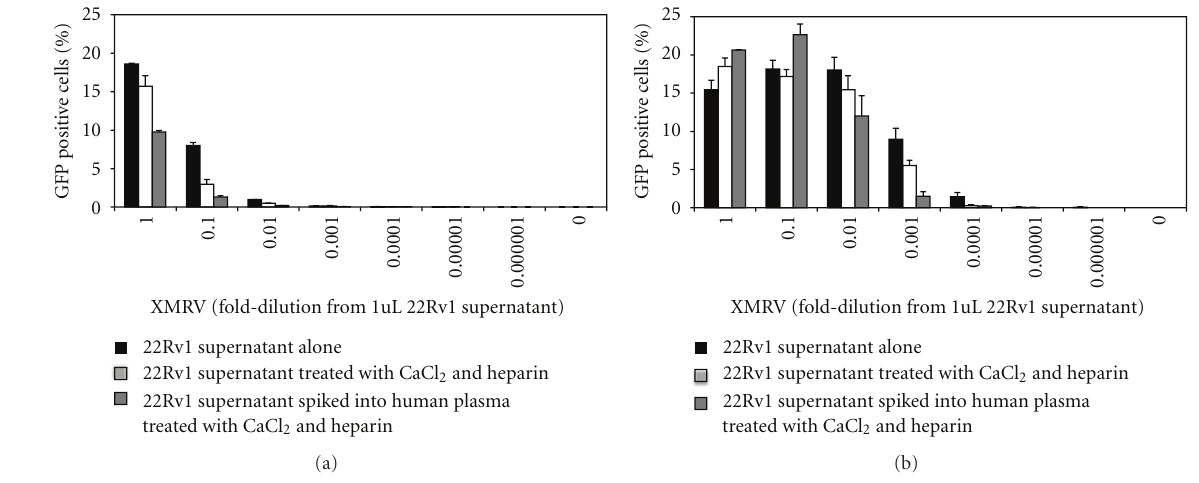
Figure 2: Verifying XMRV rescue by culturing on DERSE cells with 22Rv1 supernatants and with XMRV-spiked human plasma. XMRV culturing under the following conditions: (i) 22Rv1 supernatant alone (black bars), (ii) 22Rv1 supernatant treated with CaCl 2 + heparin (white bars), (iii) 22Rv1 supernatant spiked into human plasma treated with CaCl 2 + heparin (gray bars). GFP-positive cells were analyzed by FACS at day 4 (a) and day 8